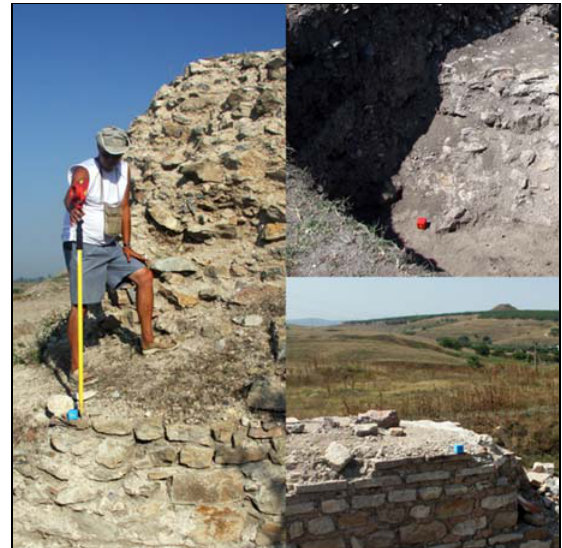
Figure 6. Colored cubes filled with sand had two roles: to help editing the photographic data in PhotoModeler and later to link between the 3D photographic model and the data taken with the total station.